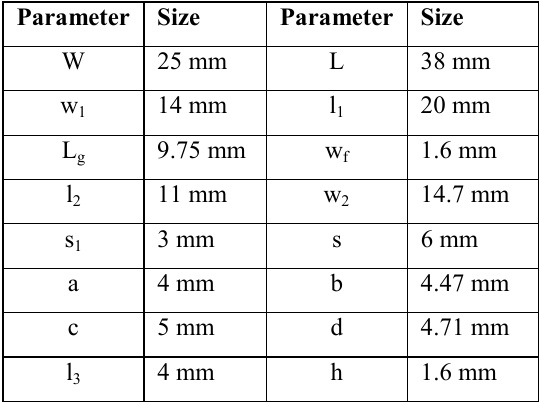
Table 1: Proposed antenna design parameters Parameter